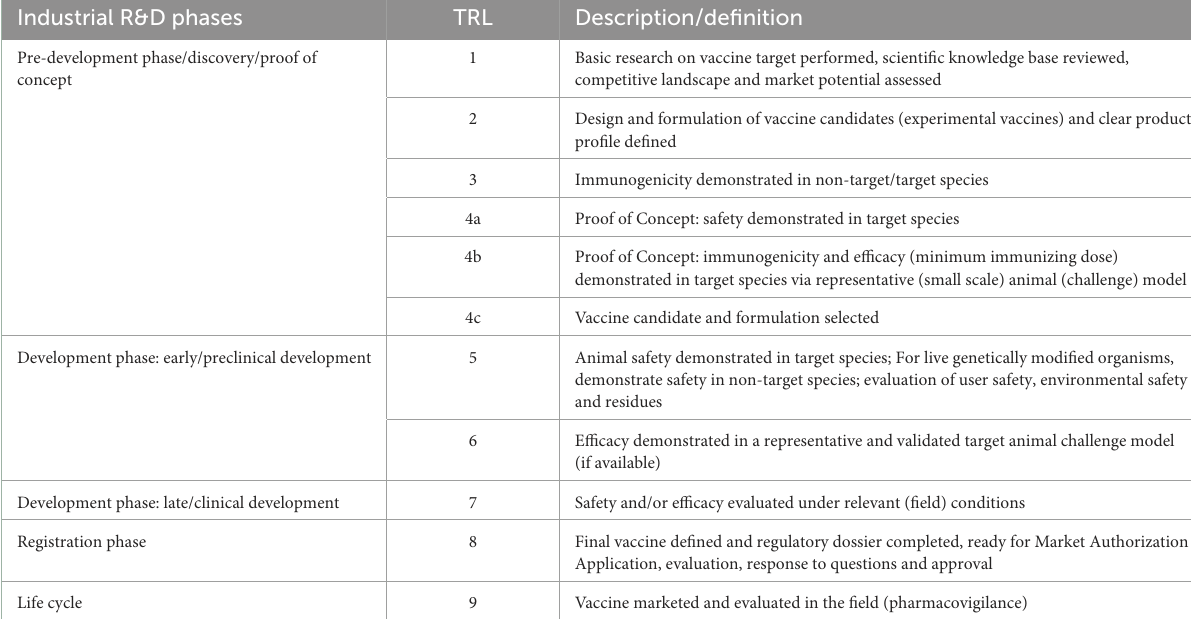
TABLE 1 Technology Readiness Levels for veterinary vaccines.